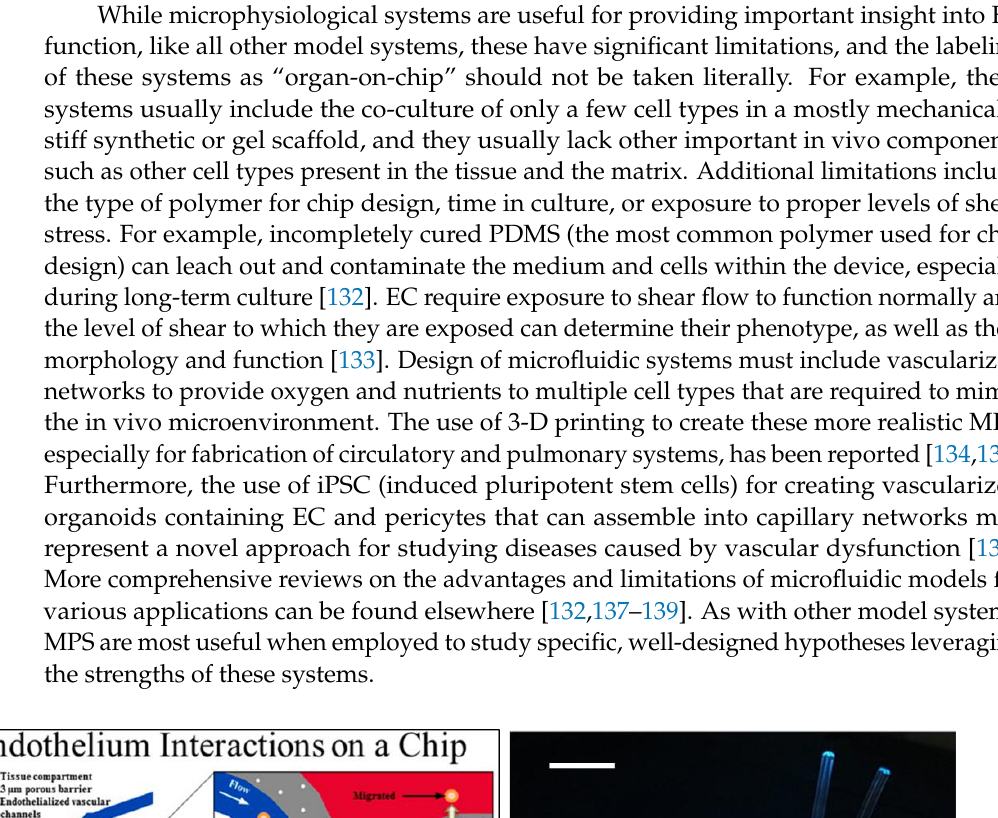
Figure 3. Endothelial cells form a complete lumen in the bMFA: ( A ) phase contrast images show endothelial cells are lined up in the direction of flow (scale bar is 100 µm). ( B ) Confocal micrograph of endothelial cells showing 3D lumen formation in the vascular channel; F-actin is labeled in green and nuclei is labeled in red. (Reproduced with permission from reference [120]).